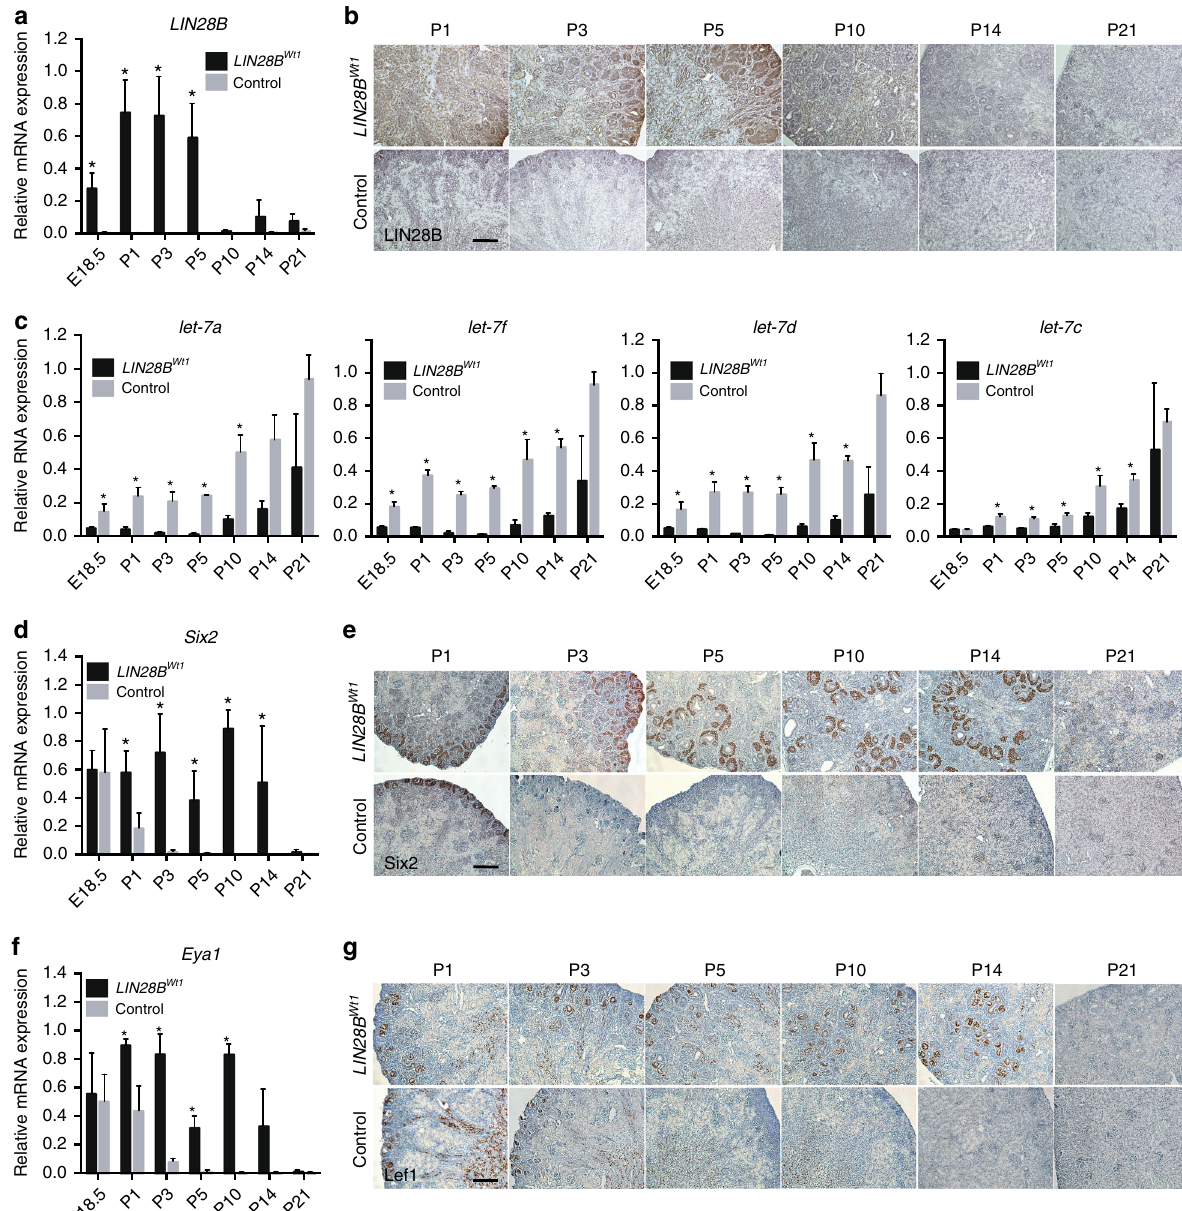
Fig. 2 LIN28B overexpression in embryonic kidney enhances nephrogenesis. a , c , d , f Relative qRT – PCR analysis measuring levels of LIN28B , mature let-7 , Six2 , and Eya1 RNAs, respectively, in LIN28B Wt1 and littermate control kidneys at the indicated developmental time points. n = 3 for each genotype. Error bars represent mean ± SD. (*) = p < 0.05, unpaired, two-tailed Student ’ s t test. b , e , g Representative immunohistochemistry staining against LIN28B, Six2, and Lef1 proteins, respectively, in LIN28B Wt1 and littermate control kidneys at the indicated developmental time points. Scale bar, 200 µ m underwent a mesenchymal to epithelial transition and subse- quently form mature nephrons throughout the renal parenchyma (Fig. 2g).